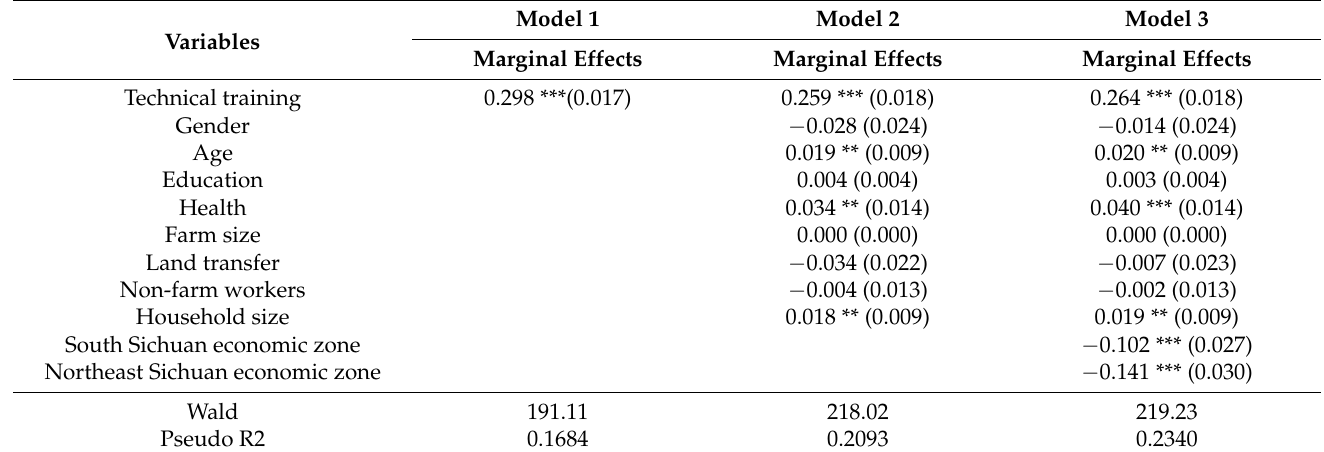
Table 3. The effects of the technical training provided by agricultural cooperatives on the farmers’ adoption of organic fertilizers: Probit model